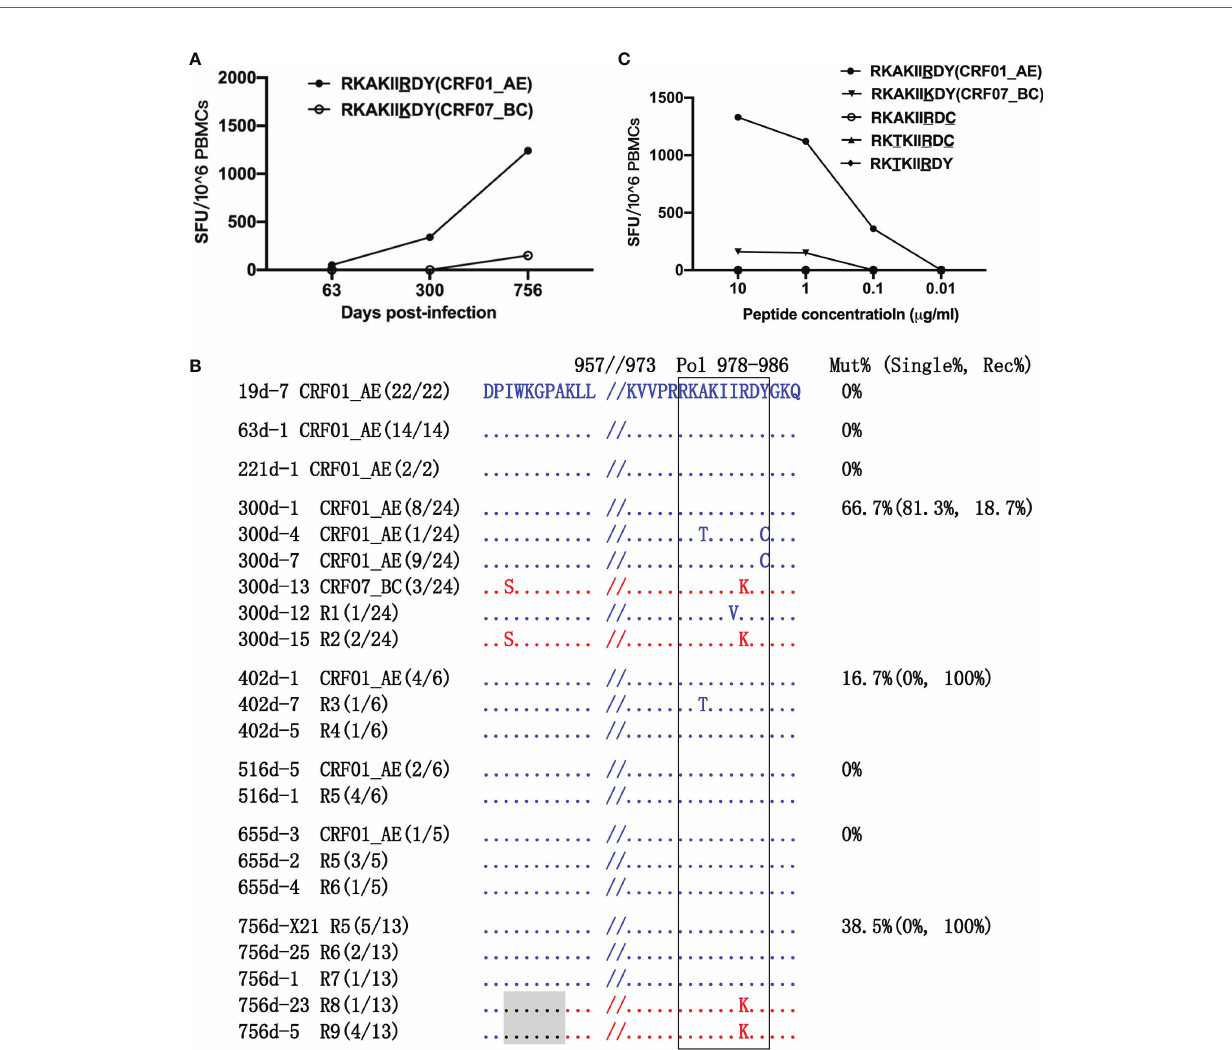
FIGURE 4 | Escape from RK9 epitope-speci fi c T-cell responses. (A) T-cell responses to the CRF01_AE-RK9 and CRF07_BC-RK9 epitopes were detected at 63, 300, and 756 days post-infection (dpi) by ELIspot. The different amino acids between the two subtype strains are underlined. (B) The amino acid alignment of partial regions of the Pol protein covering the RK9 epitope and its fl anking regions at different time points. Sequences derived from the CRF01_AE strains are highlighted in blue. Those derived from the CRF07_BC strains are highlighted in red. The recombination breakpoints are shaded gray. The amino acids of the RK9 epitope are boxed in black. The number in parentheses indicates the number of clones with the reported sequence. The percentages of sequences with epitope mutation (Mut %) and the percentage of single (Single%) or recombinant sequences (Rec%) are listed. (C) Responses to various variants within the RK9 epitope were detected using peripheral blood mononuclear cells (PBMCs) at 756